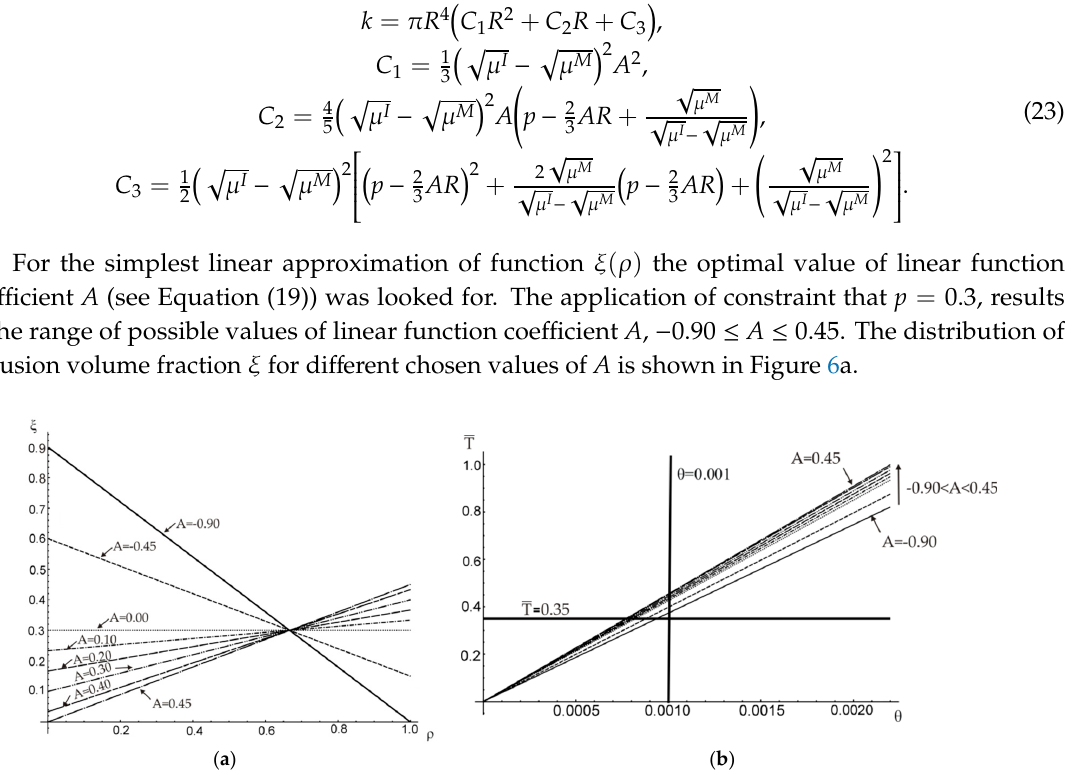
Figure 6. ( a ) Changes of the inclusion volume fraction along the radius of a shaft; ( b ) the external torque versus the unit angle of